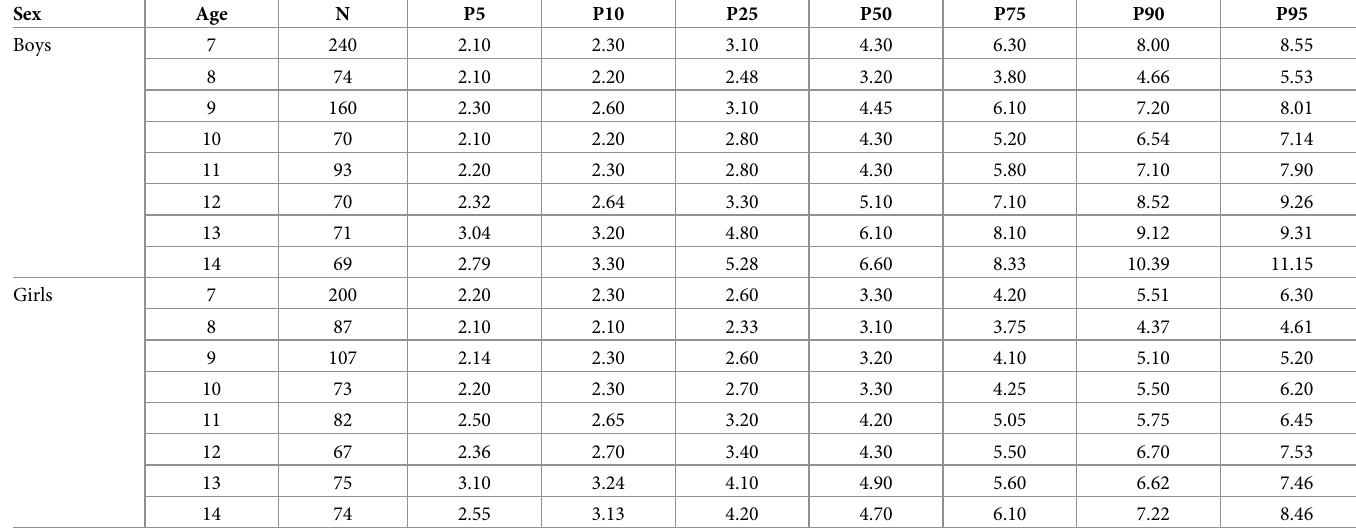
Table 3. Sex- and age-specific normative reference values for the maximal number of levels achieved after the 20-m shuttle run test ( N = 1,612). Sex Age N